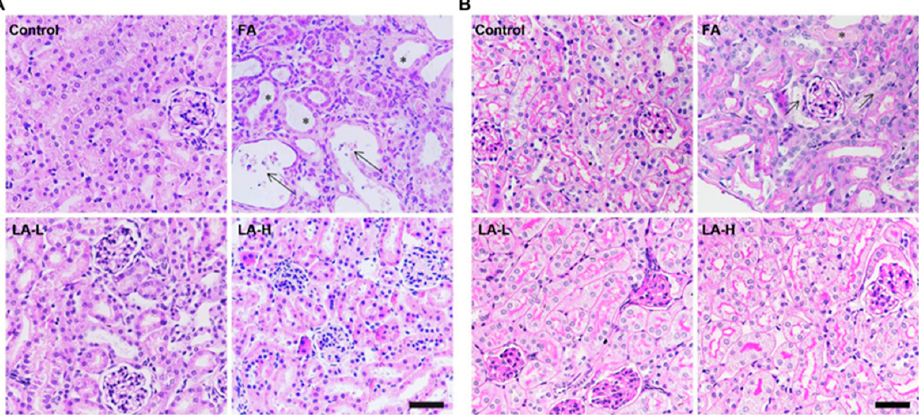
Figure 6. Protective effects of lipoic acid on folic acid-induced kidney injury. Histological staining of the kidney tissues derived from control, folic acid (FA), and folic acid + lipoic acid (LA). This figure was reproduced from reference [105]. ( A ) Representative images of hematoxylin & eosin (H&E) staining reflecting the histological changes in folic acid-induced acute kidney injury and low- and high-ALA-treated animal groups. ( B ) Renal damage assessed by Periodic acid/Schiff staining in folic acid-induced acute kidney injury and low- and high-ALA-treated animal